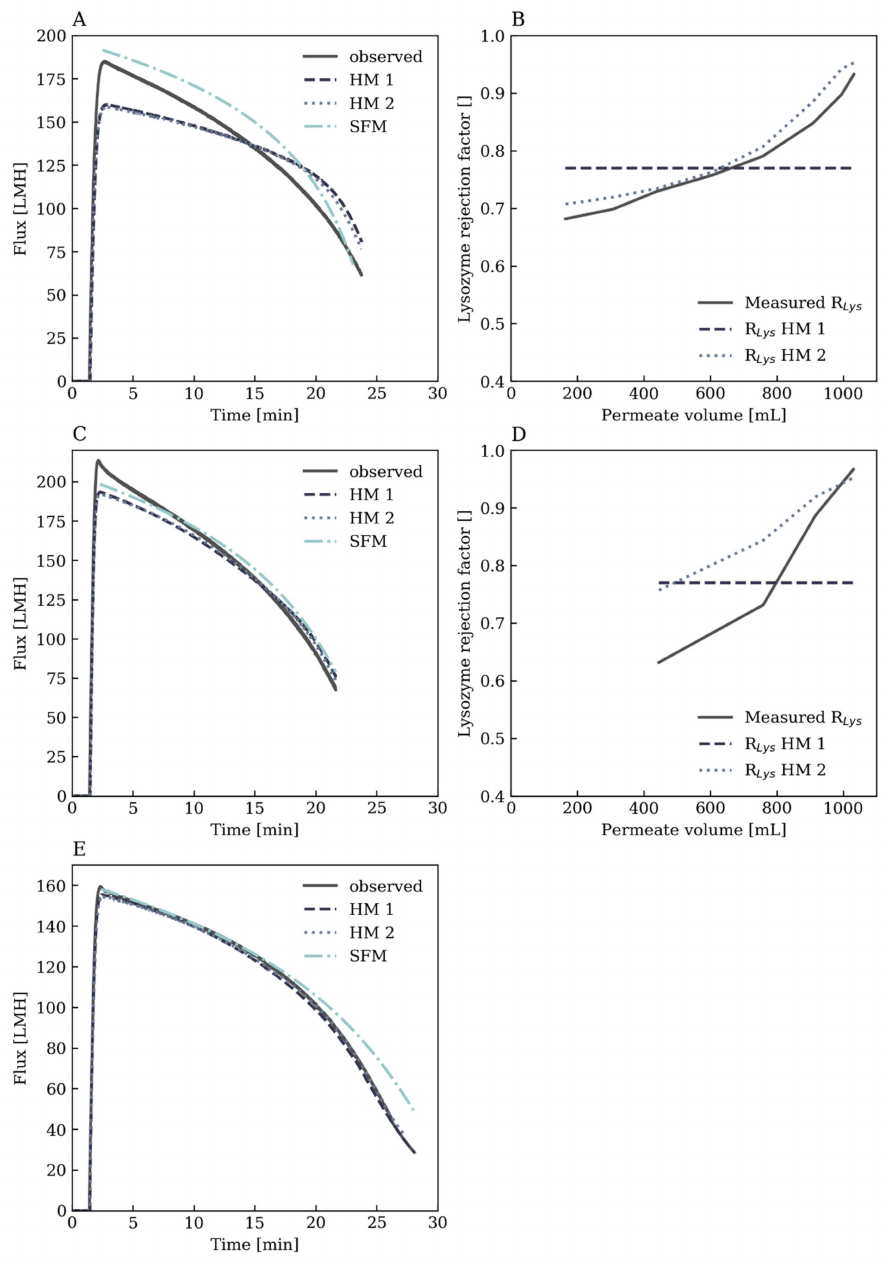
Figure A4. Comparison between observed and predicted flux and R Lys . ( A ) The flux of test run 8 over time, ( B ) R Lys over permeate volume of test run 8, ( C ) the flux over time of test run 3, ( D ) R Lys over permeate volume of test run 3, ( E ) the flux over time of test run